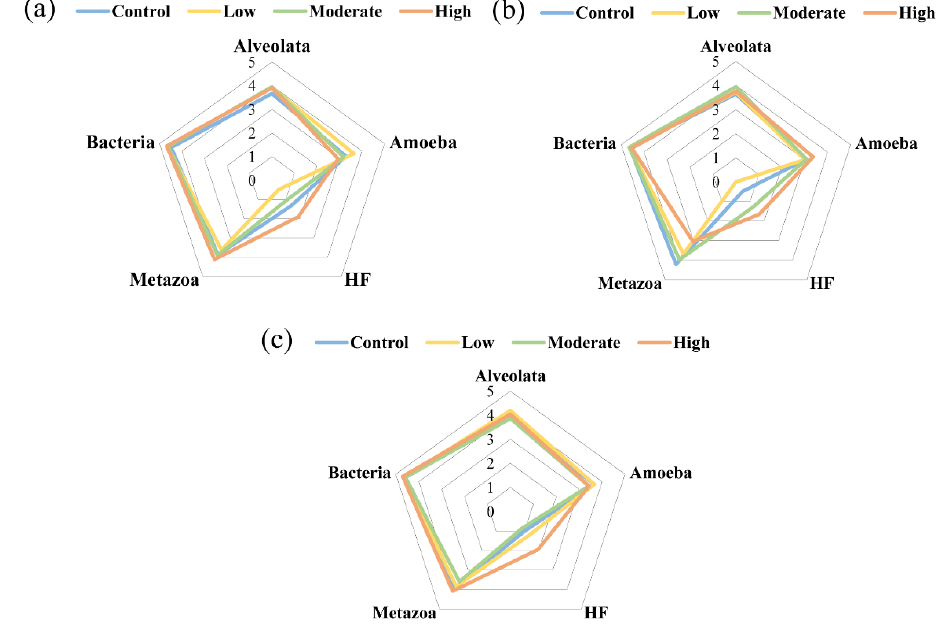
Figure 5. The main components in the obtained microbial food web during different periods. Loga- rithms (log10) taken for biomass reduce absolute errors. ( a ) Day 6; ( b ) Day 12; ( c ) Day 18. Control: the sediment with no paroxetine added ; Low: 10 μg/L paroxetine; Moderate: 100 μg/L paroxetine; High: 1000 μg/L paroxetine.